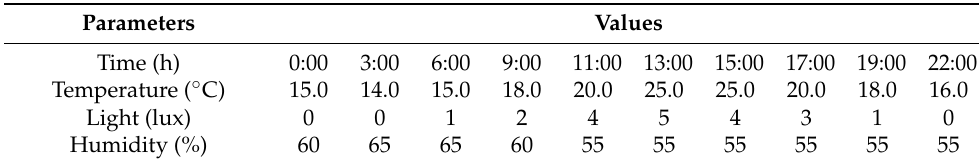
Table 6. Optimal parameters for proper growth of wheat